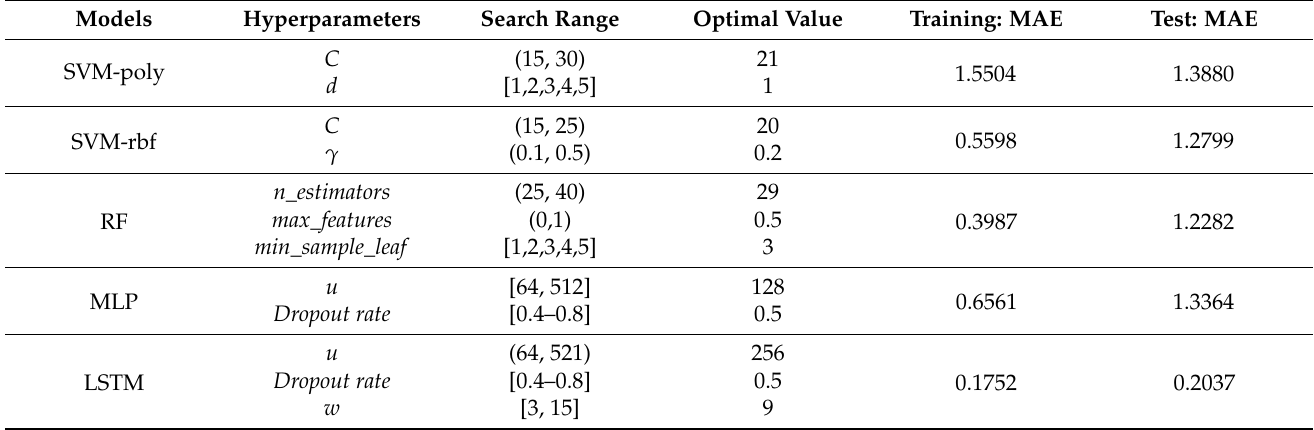
Table 1. Basic information of model parameter